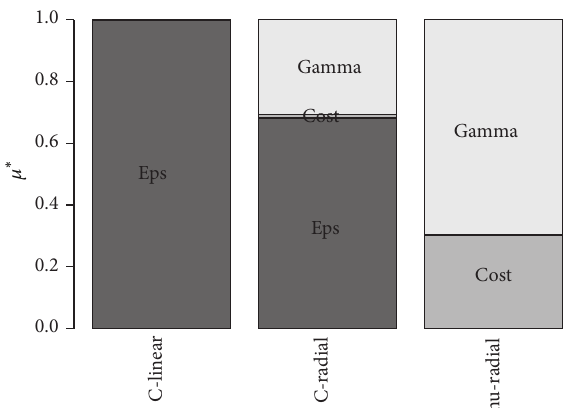
Figure 3: Morris global sensitivity analysis, scaled 𝜇 ∗ indices determined for the SVM models estimating soil water content for the potential − 0.98